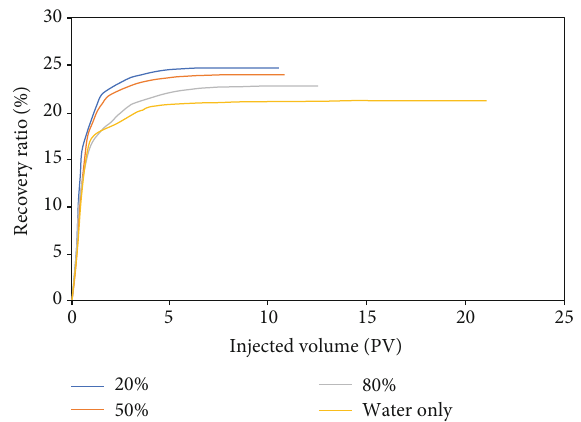
Figure 7: Curve of the relationship between injection volume of alternating gas-water fl ooding and sweep e ffi ciency in di ff erent times.